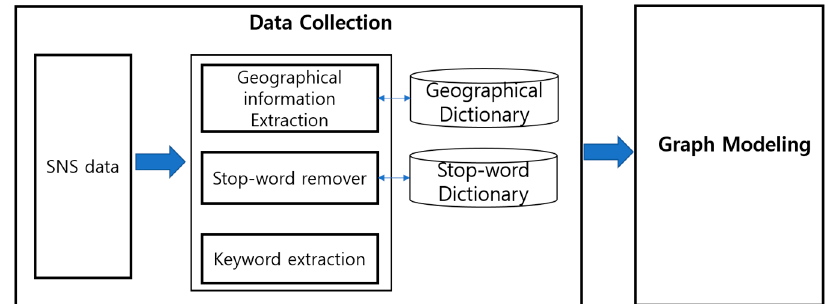
Figure 2. Processing procedure of the data collection.